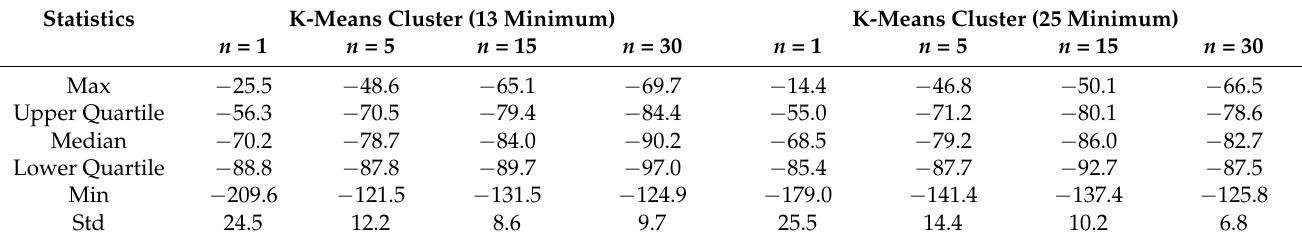
Table 2. Summary of storage depletion rate calculation statistics for the k-means clustering algorithm using 500 random data sets scenarios using different minimum points per cluster and a different number of randomly selected points for the measured wells (values in mm 3 per